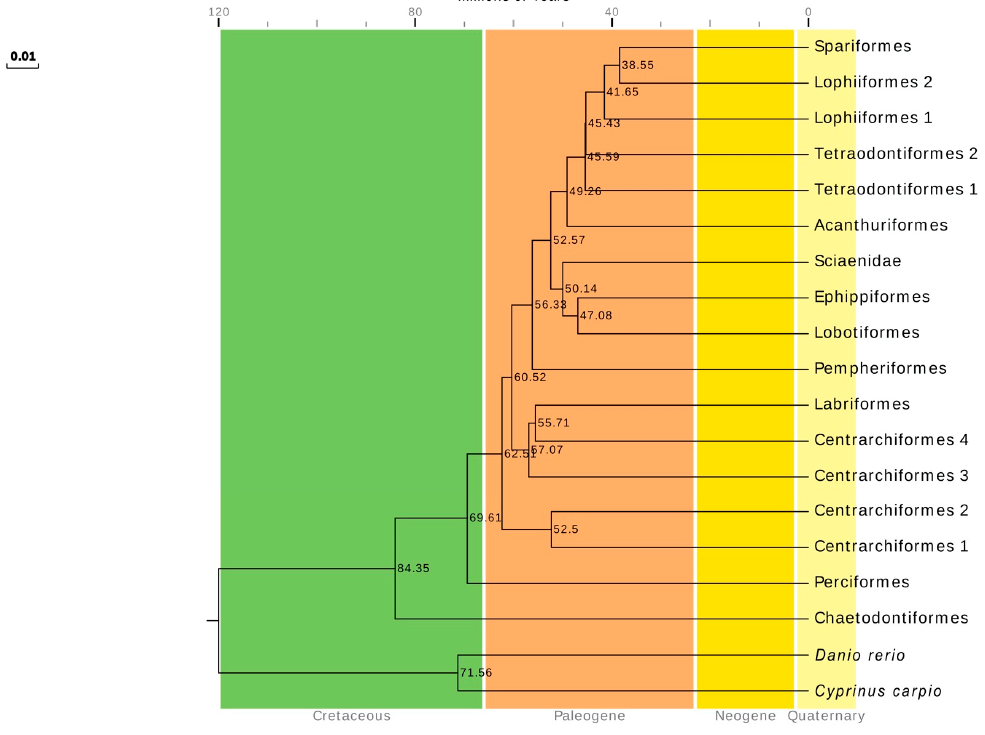
Figure 9. Chronogram for the 204 species of Series Eupercaria including 2 out-groups ( Cyprinus carpio and Danio rerio ) based on the Bayesian topology resulting from analysis of the 13 PCGs genes. Divergence times were estimated using three calibrations. Numbers near the nodes indicated the average divergence time estimated (million years, Mya). The geological time scales were Cretaceous, Paleogene, Neogene, and Quaternary, respectively.